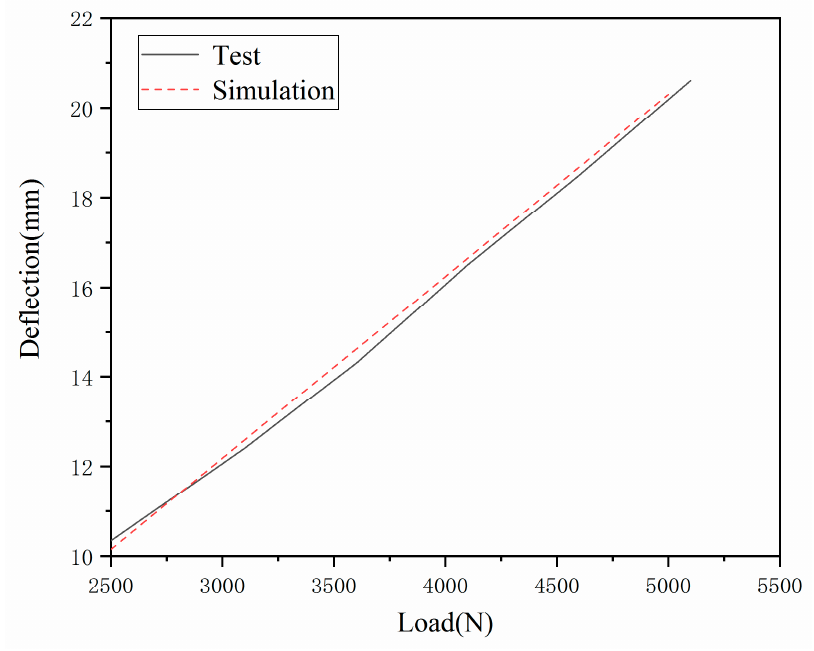
Figure 8. The deflection vs. vertical load.